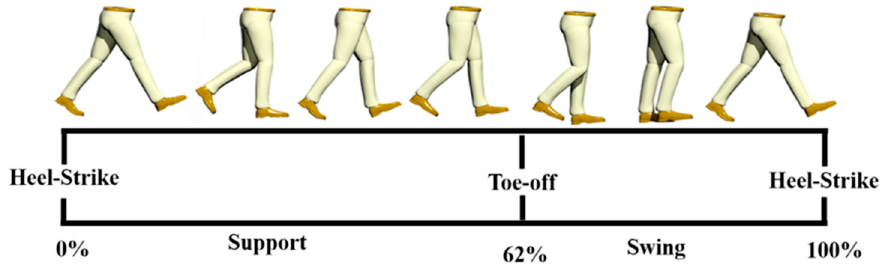
Figure 1. Phases of the walking cycle.